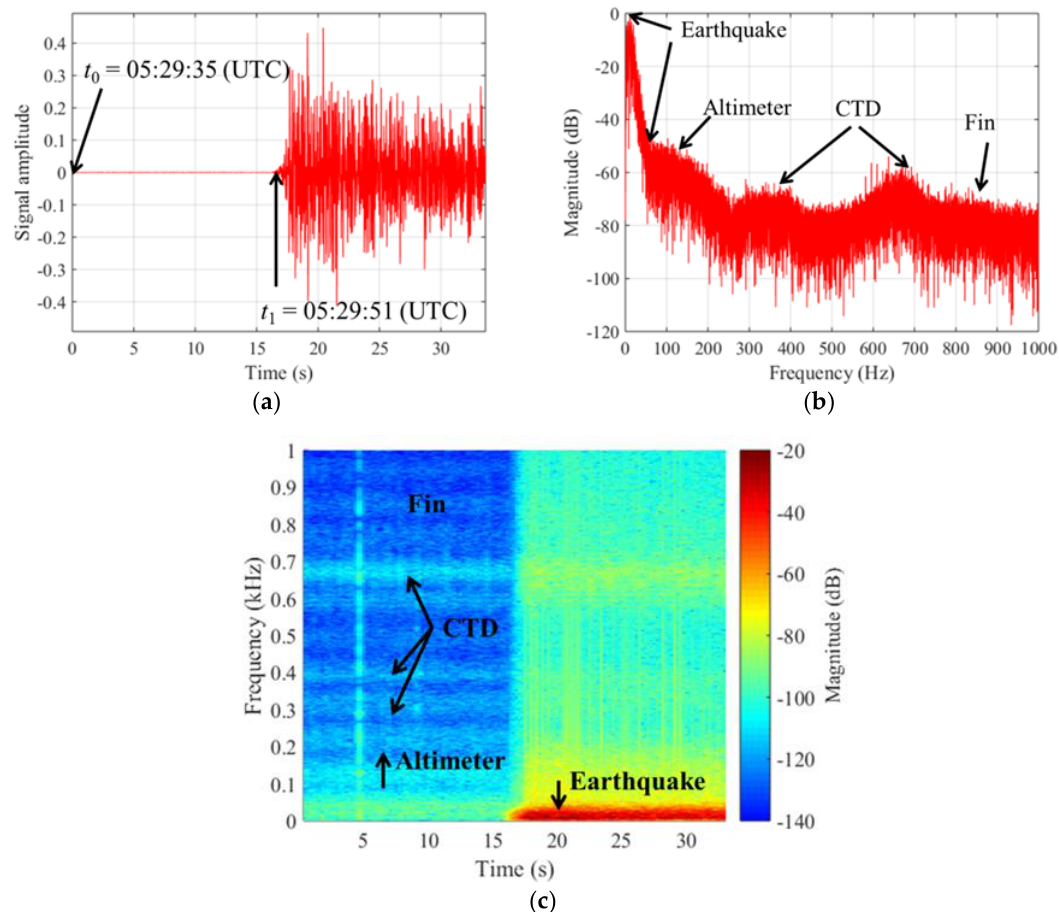
Figure 9. The earthquake acoustic signal : ( a ) Time reconstructed signal, ( b ) frequency spectrum and ( c ) Spectrogram.